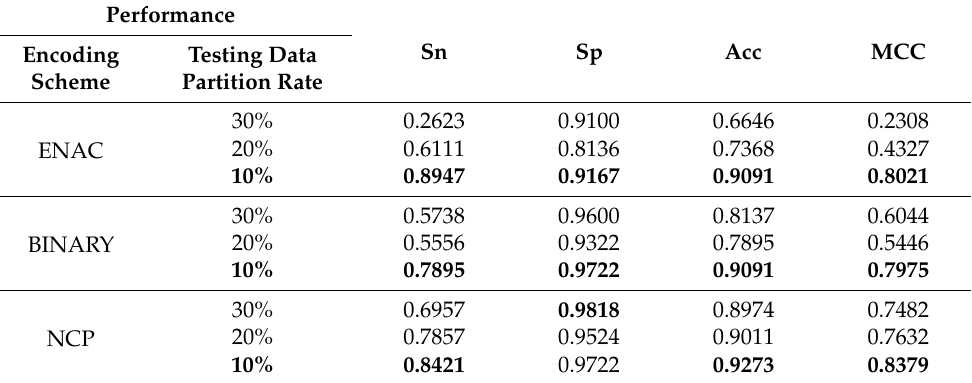
Table 2. Performance of ENAC, BINARY, and NCP with different testing data partition rates by